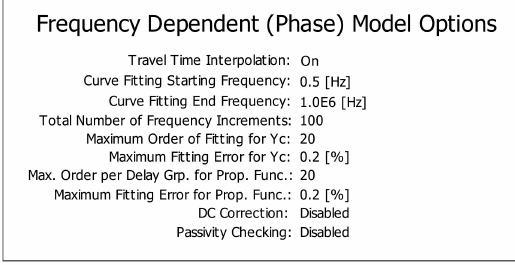
Figure A1. Line model of overhead lines.